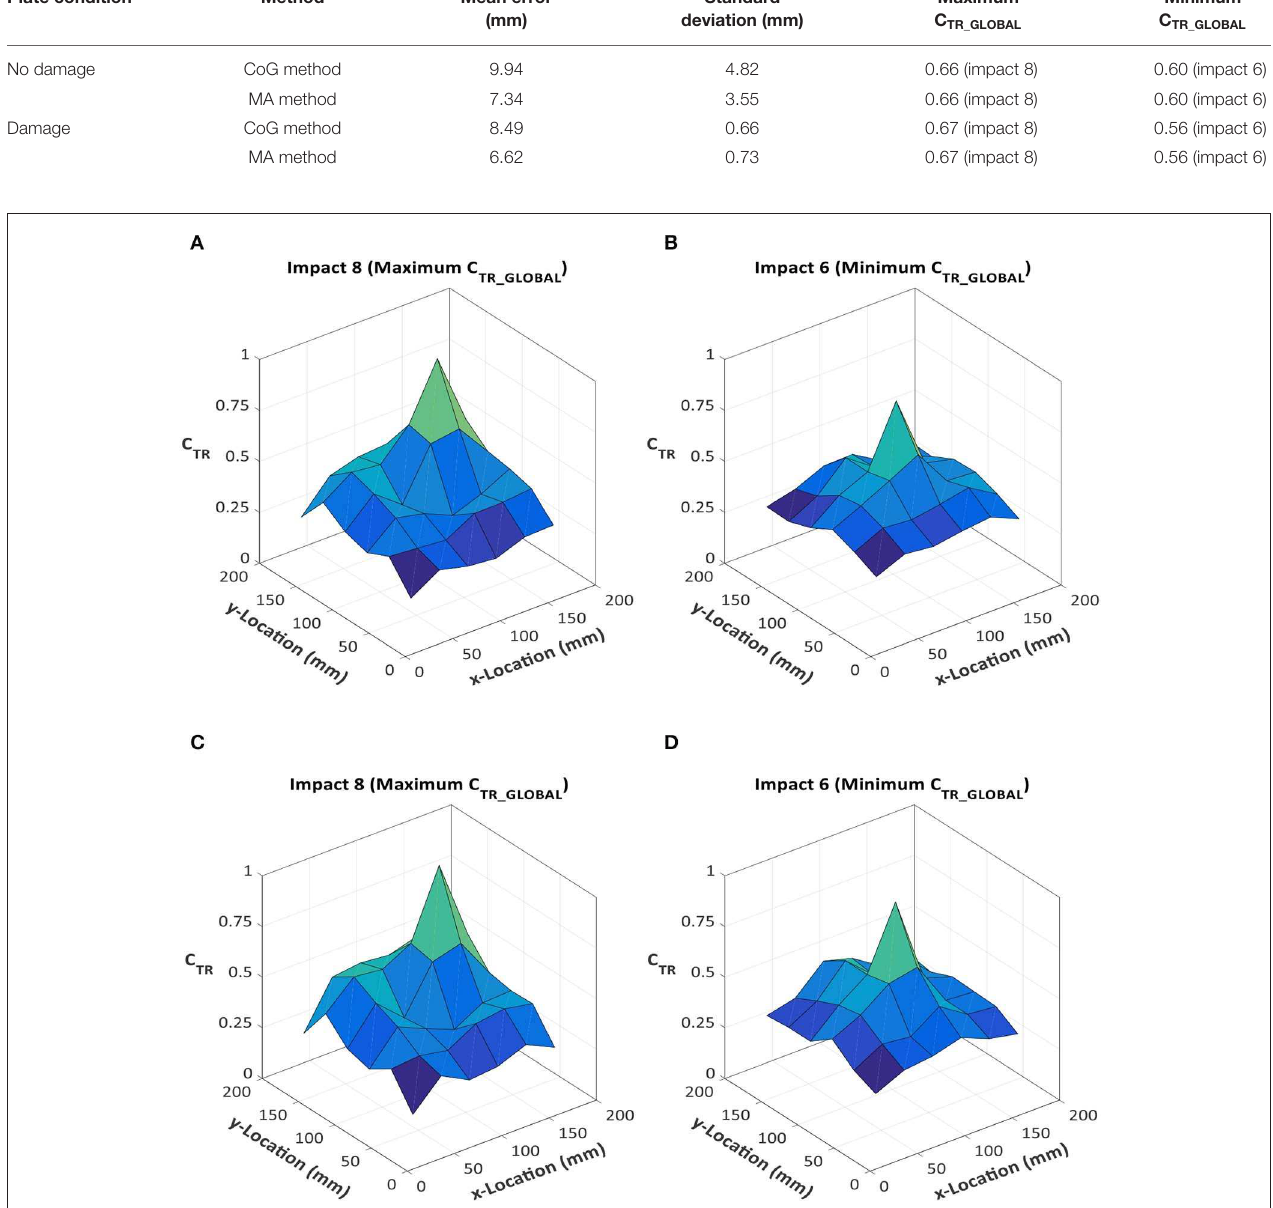
FIGURE 12 | C TR distributions for impacts associated to the maximum and minimum C TR_GLOBAL values, combined and a grid refinement factor of 2, both with and without damage present. (A) No damage maximum C TR_GLOBAL ; (B) no damage minimum C TR_GLOBAL ; (C) same impact location as (A) with damage; (D) same impact location as (B) with